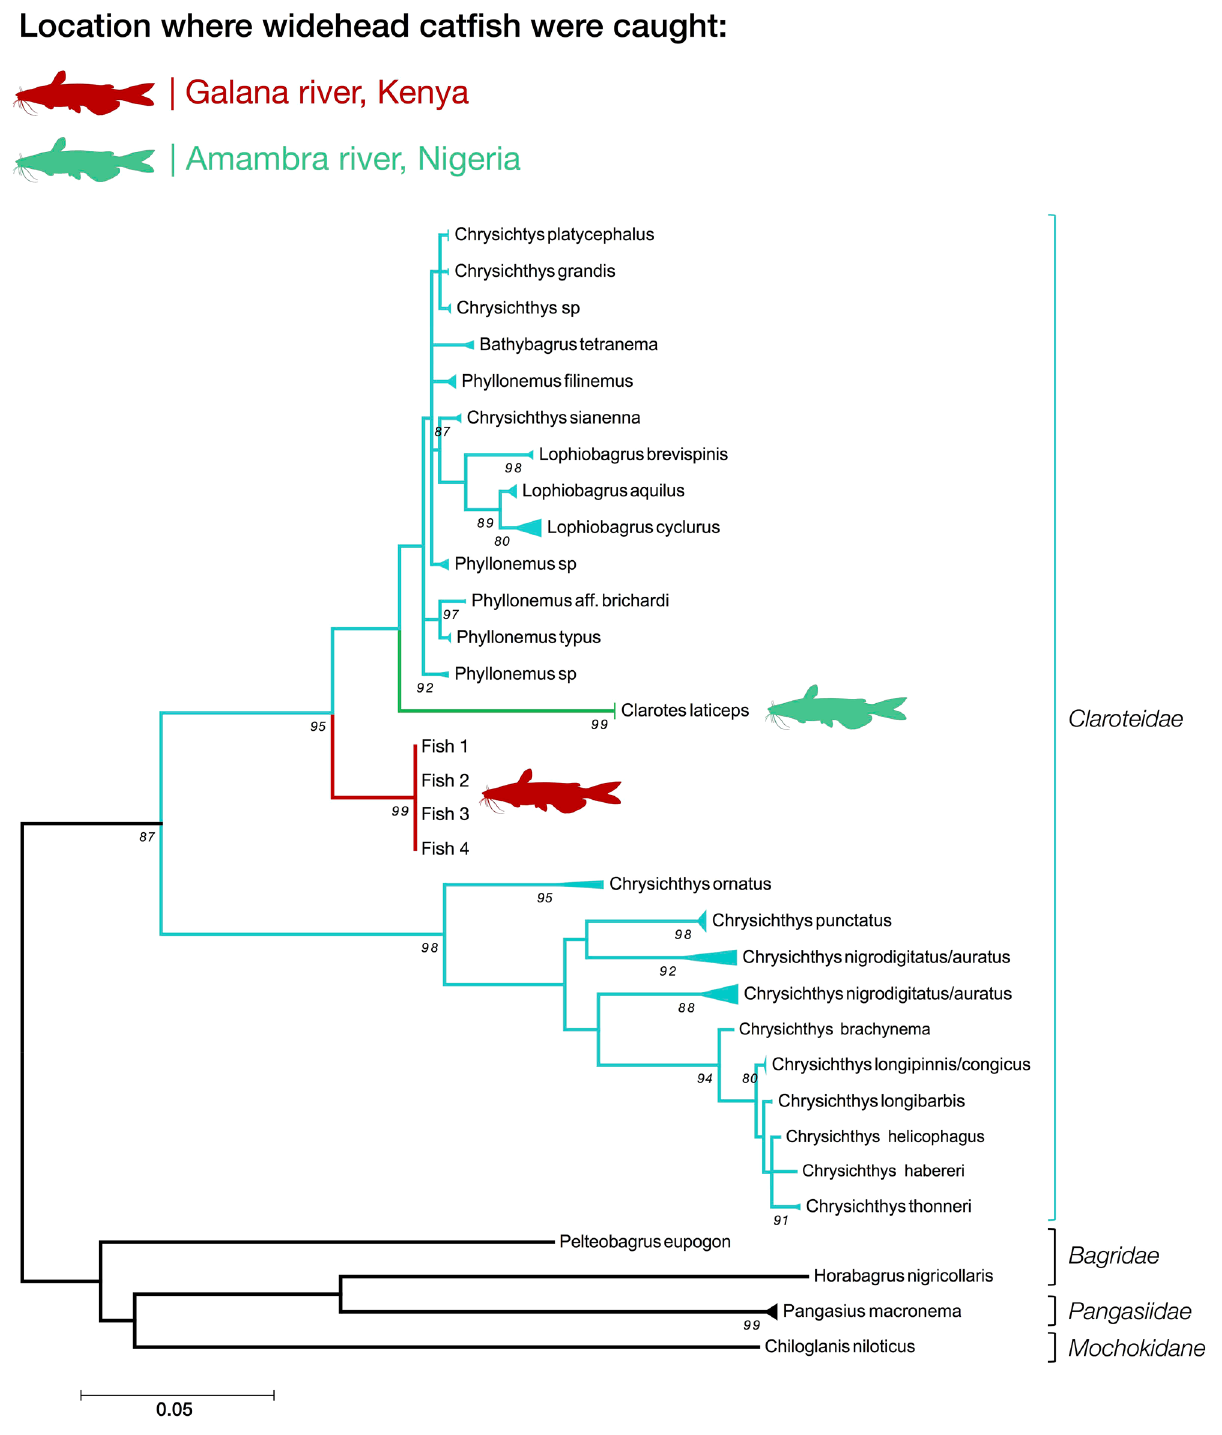
Figure 3. The ML tree generated using the catfish COI sequences. Highlighted in red are the COI sequences of the widehead catfish collected from the Galana river. Highlighted in green are COI sequences corresponding to widehead catfish collected in the Amambra river,